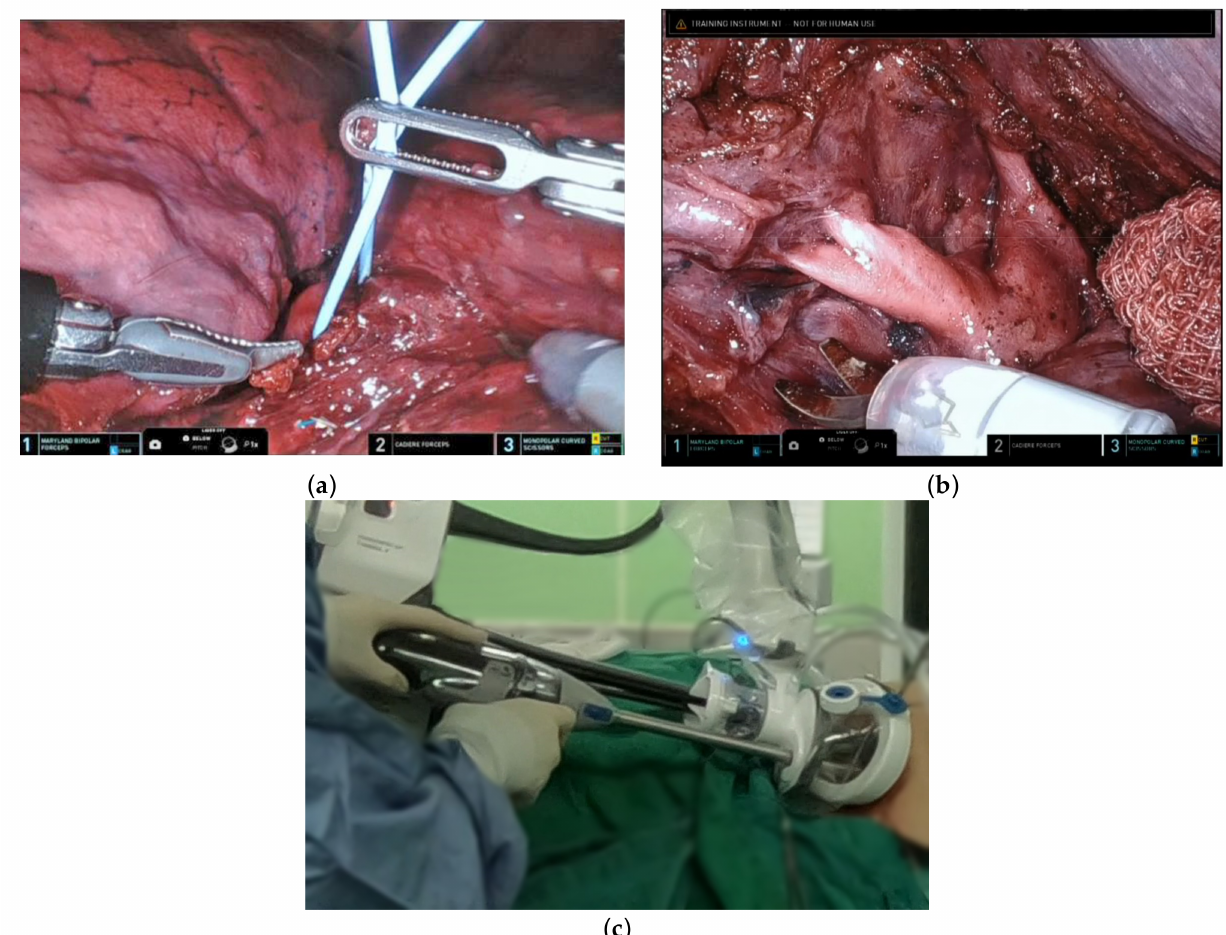
Figure 4. The target pulmonary artery was encircled with a vessel loop. ( a ) Expansion of the working space to allow safe entering of the staple was achieved through ( b ) an extensive dissection along the pulmonary vessels. ( c ) The stapler was introduced through the assistant port of the da Vinci ® SP Access Port Kit via a subcostal